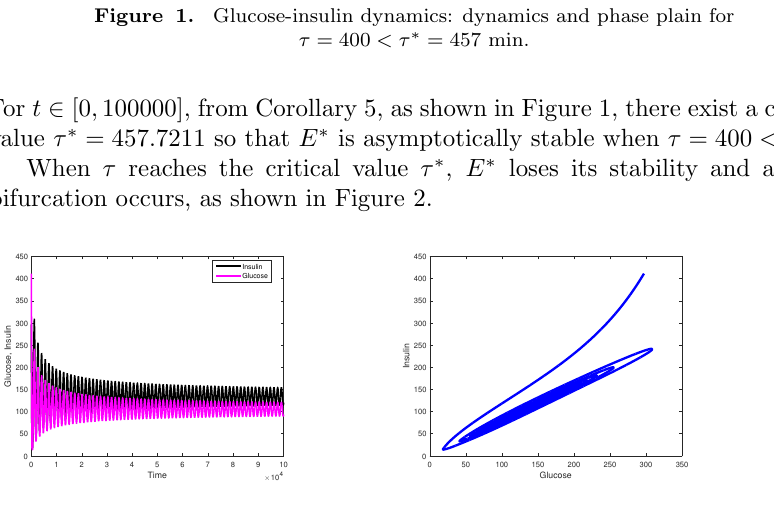
Figure 2. Glucose-insulin dynamics: dynamics and phase plain for τ ∗ = 457 min.